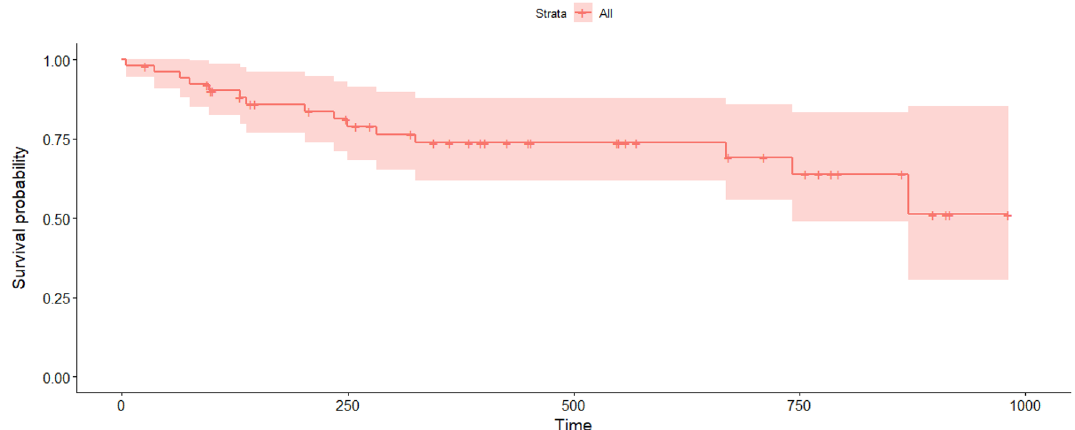
Figure 3. Curve of the overall survival probability of Eurasian lynx (N = 52) released in 2019–2021, estimated with the Kaplan–Meier method (time expressed in days; the area shaded pink represents the 95% confidence interval).